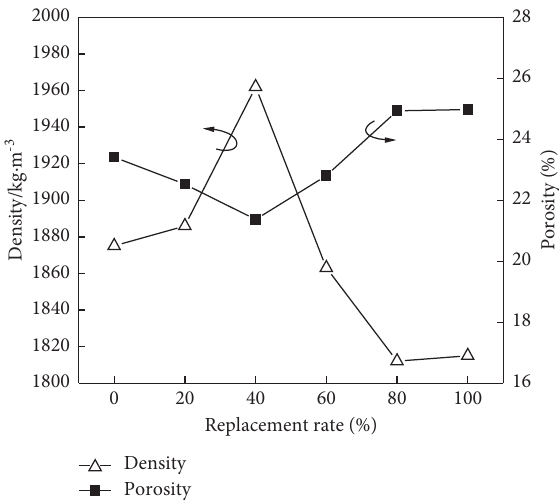
Figure 4: Relationships between porosity, density, and replace- ment rate of